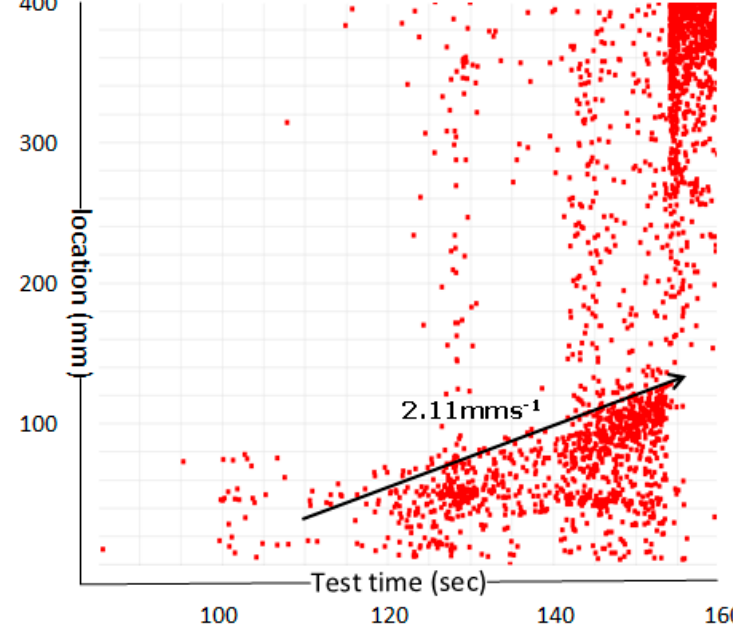
Figure 6. Acoustic emission localization during plydrop specimen static loading.